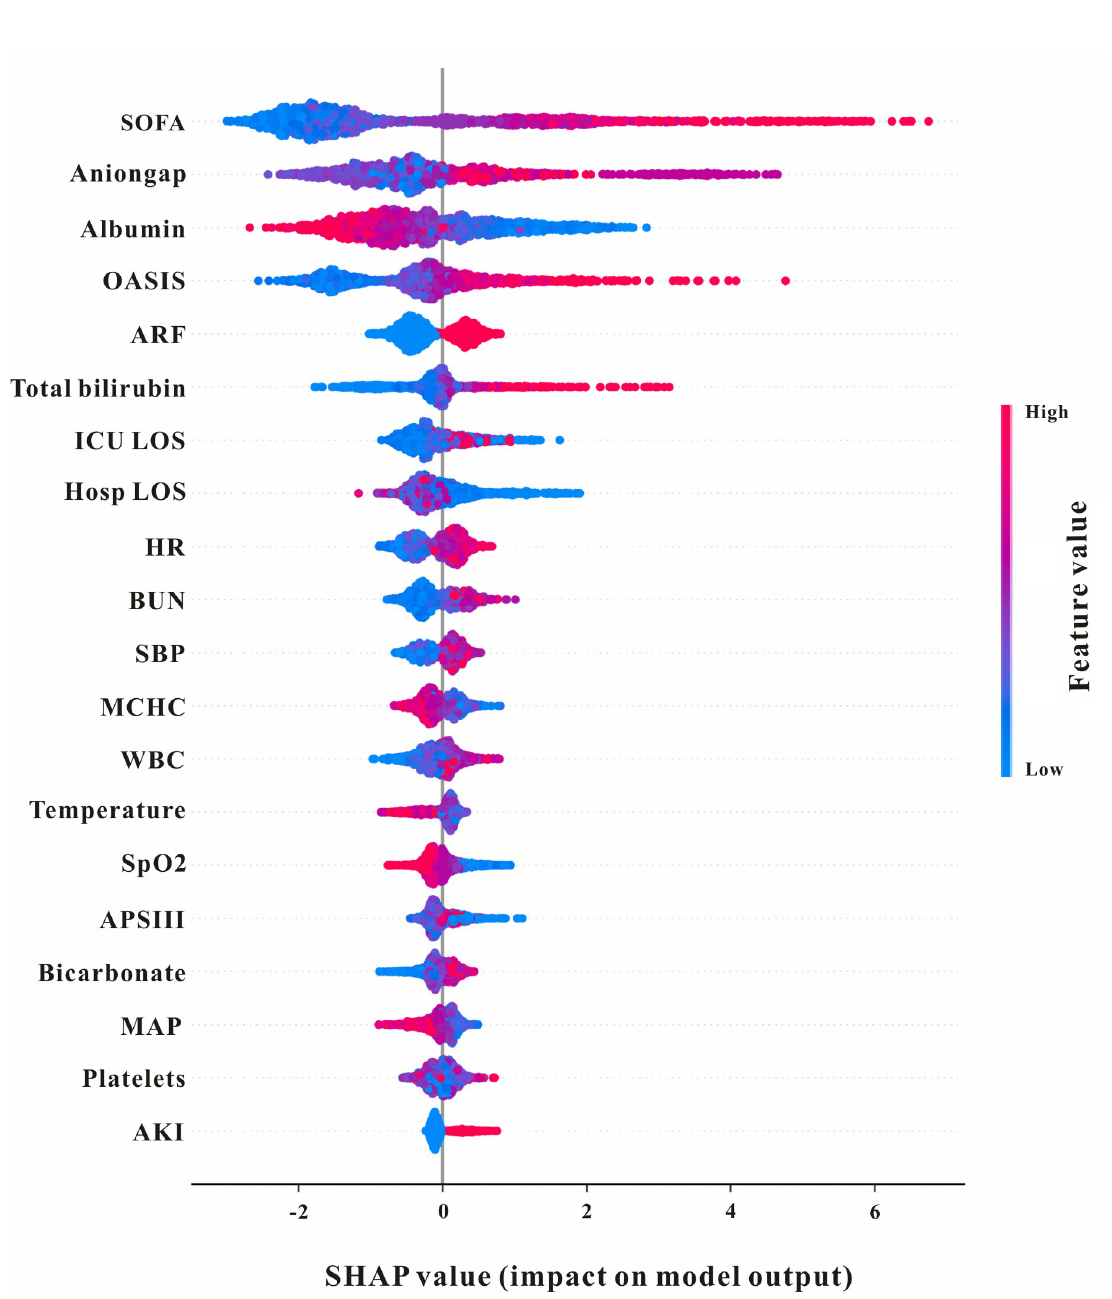
Fig 4. SHAP summary plot of the features of the XGBoost model. The higher the SHAP value of a feature, the higher the probability of in-hospital mortality development. A dot is created for each feature attribution value for the model of each patient, and thus one patient is allocated one dot on the line for each feature. Dots are colored according to the values of features for the respective patient and accumulate vertically to depict density. Red represents higher feature values, and blue represents lower feature values.